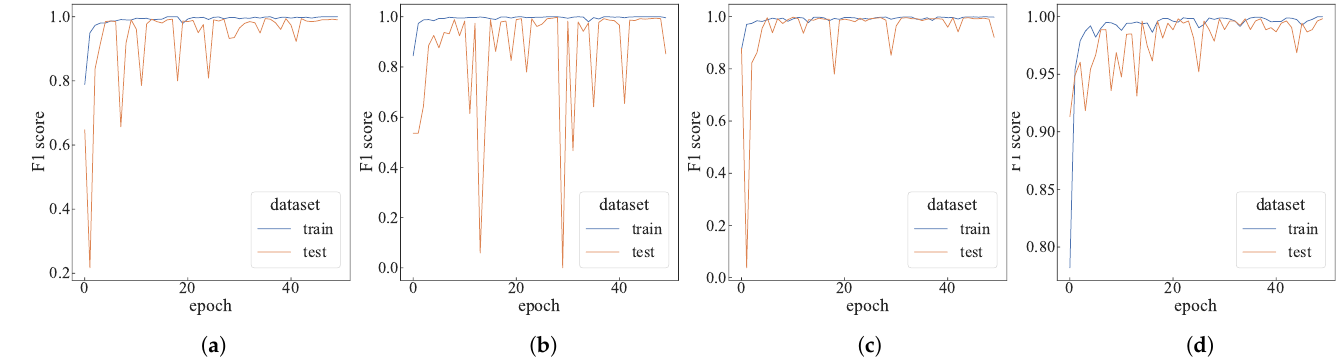
Figure 15. The F 1-score of different models. ( a ) GhostNet 1.0 × ; ( b ) MobileNetV3 Small; ( c ) Res2Net- 50; ( d ) ShuffleNetV2 1.0 × . Table 2. Performance comparison of the different